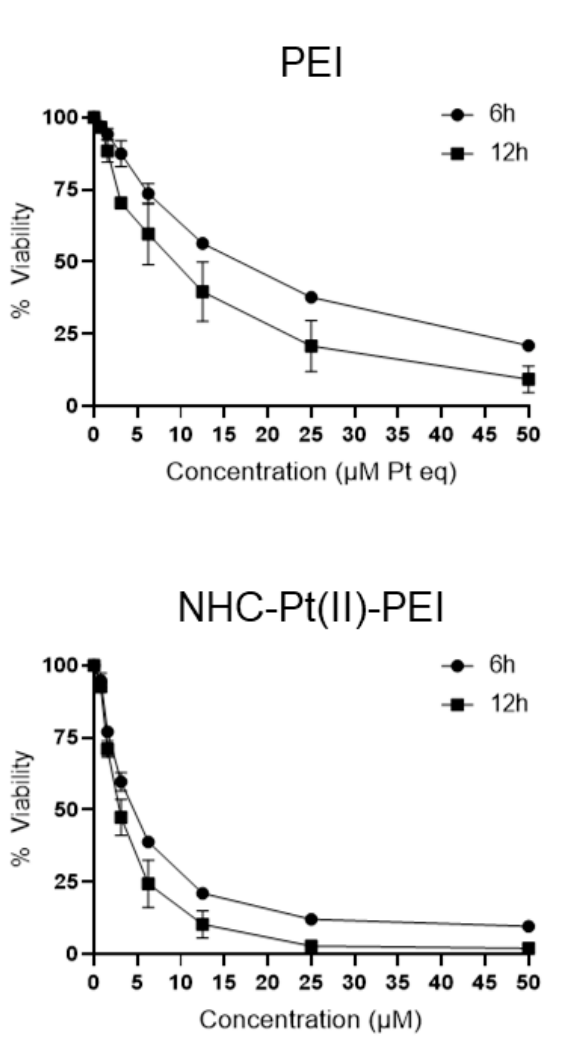
Figure 4. PEI and NHC-Pt(II)-PEI cell death kinetics. Cell viability curves of 6 h and 12 h PEI and NHC-Pt(II)-PEI treated NCH421K spheroids were measured via the CelltitreGlo 3D cell viability assay. Values are the mean of n = 3 independent replicates ± one SEM.